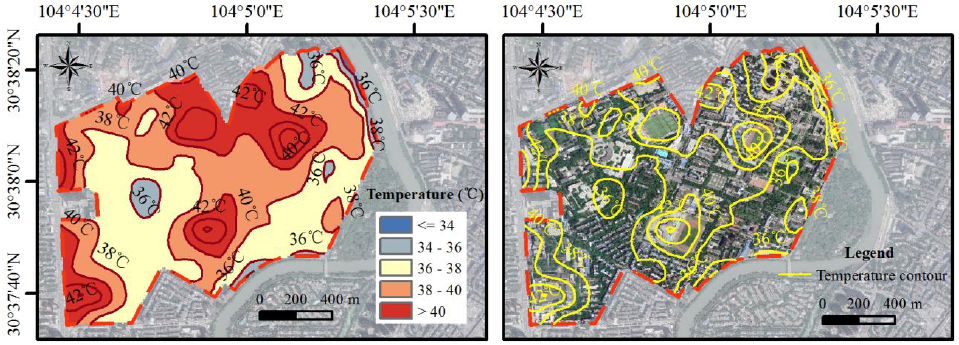
Figure 12. Thermal landscapes.